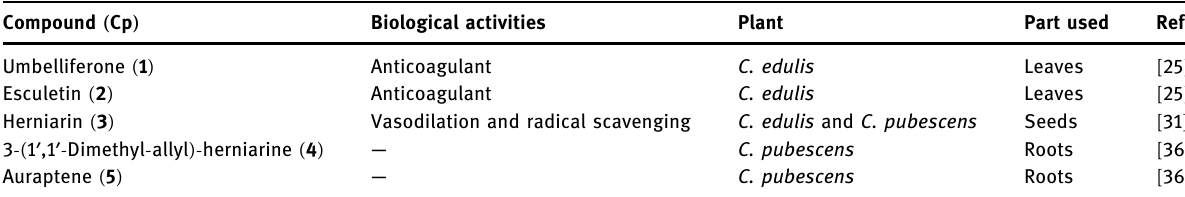
Table 1: Pharmacological properties of compounds obtained from Casimiroa species Compound ( Cp )